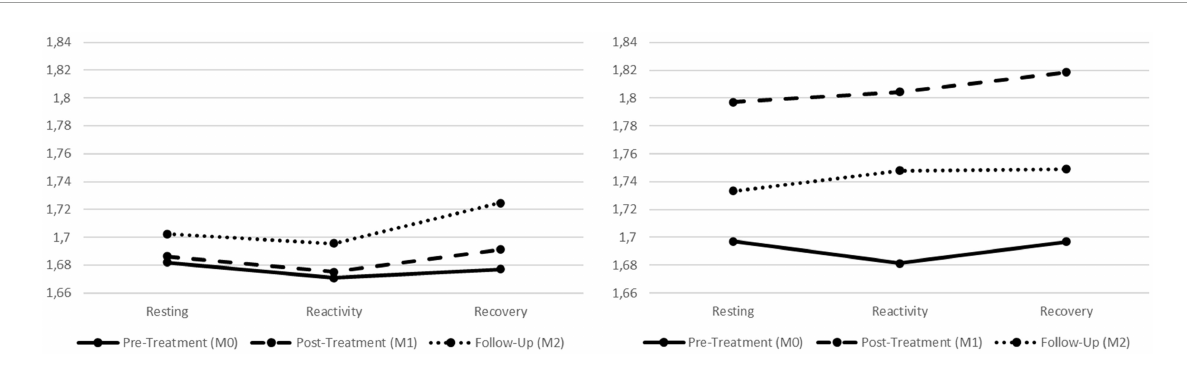
FIGURE3 Graphic presentation of the treatment and control groups’ physiological correlates for the different phases of the standardized procedure (SP), across the pre-treatment, post-treatment, and follow-up assessment periods. Left graph refers to the treatment group and right graph refers to the control group. Both graphs refer to the square root of the mean of the sum of the squares of differences between adjacent NN intervals (RMSSD) index.